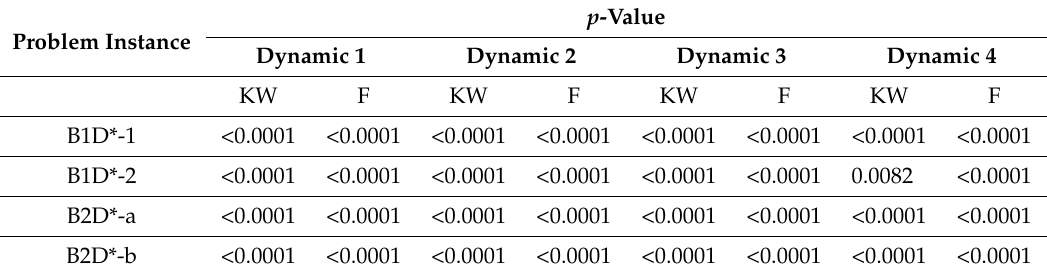
Table 5. Results of the 95%-confidence Kruskal–Wallis (KW) and Friedman (F) tests. The symbol (*) after letter ‘’D” in the Problem column refers to the type of dynamic used according to columns Dynamic . A p -value less than 0.05 means that there are significant differences among the compared algorithms in such